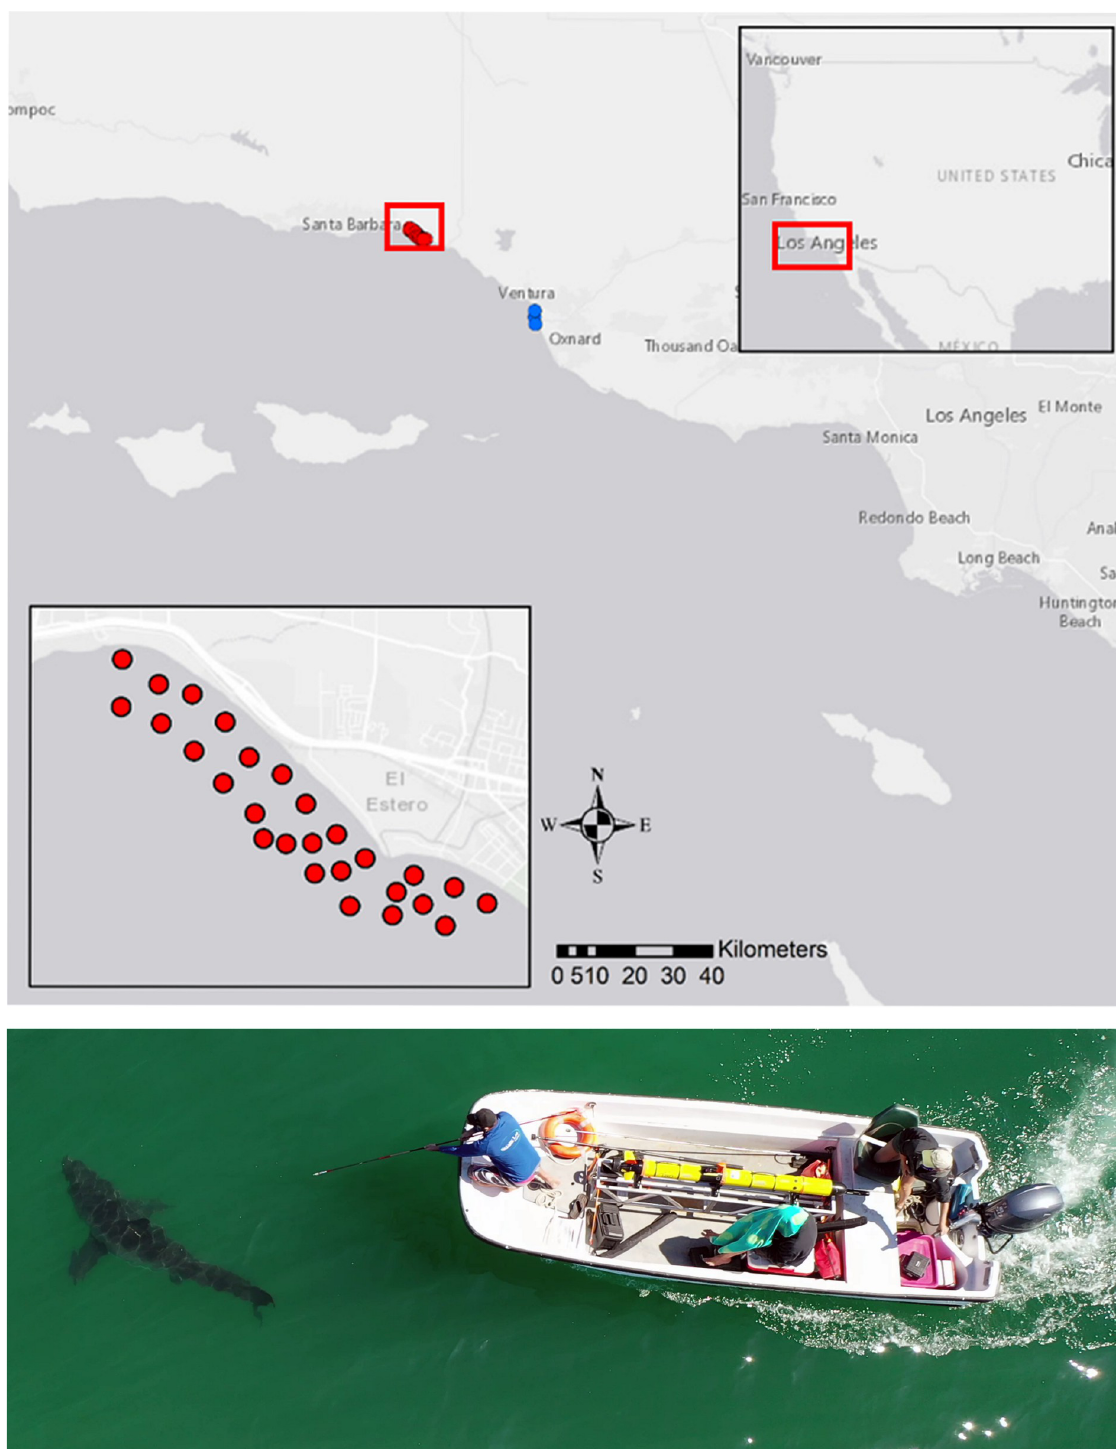
Fig 1. White shark tagging and study location. Main map (top) shows the location of the VPS array (red dots) just North of Carpinteria, CA, USA, as well as three acoustic monitoring locations off Ventura, CA, USA (blue dots). Inset map shows area magnified view of the study area and VPS array. Basemap and map data were produced in ArcGIS software by ESRI, using map imagery available from USGS (https:// apps.nationalmap.gov/viewer/). Image (bottom) shows a juvenile white shark being tagged within the VPS array.